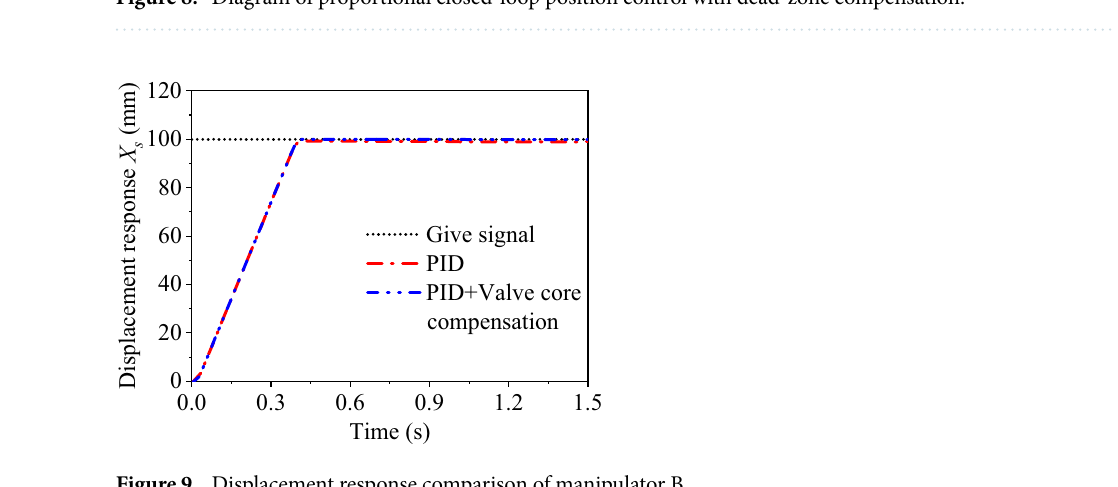
Figure 8. Diagram of proportional closed-loop position control with dead-zone compensation.